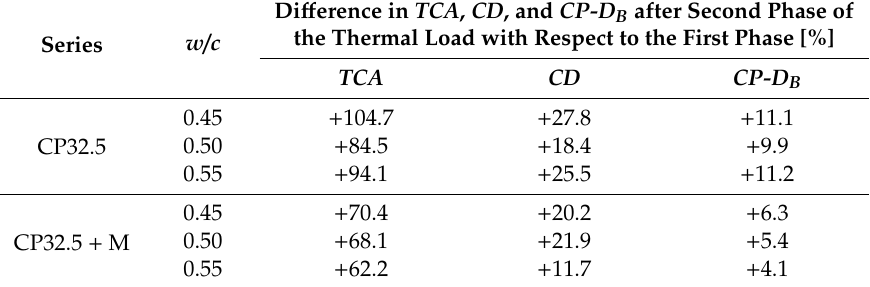
Table 3. Changes in the characteristics of cracks between the first and second phase of the thermal load. Di ff erence in TCA , CD , and CP-D B after Second Phase of the Thermal Load with Respect to the First Phase [%] Series w / c TCA CD CP-D B 0.45 + 104.7 + 27.8 + 11.1 0.50 + 84.5 + 18.4 + 9.9 CP32.5 0.55 + 94.1 + 25.5 + 11.2 0.45 + 70.4 + 20.2 + 6.3 0.50 + 68.1 + 21.9 + 5.4 CP32.5 + M 0.55 + 62.2 + 11.7 +